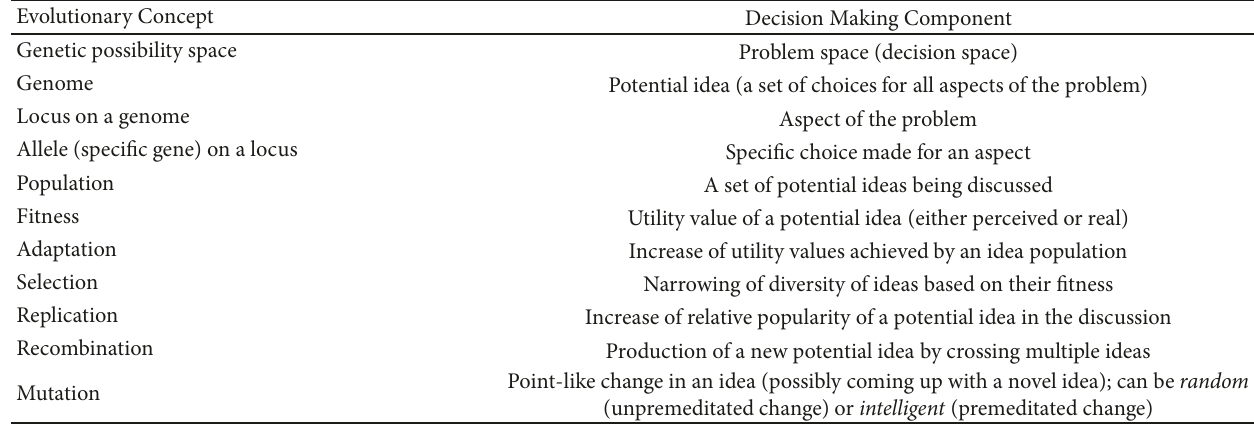
Table 1: Evolutionary concepts applied to corresponding decision making process